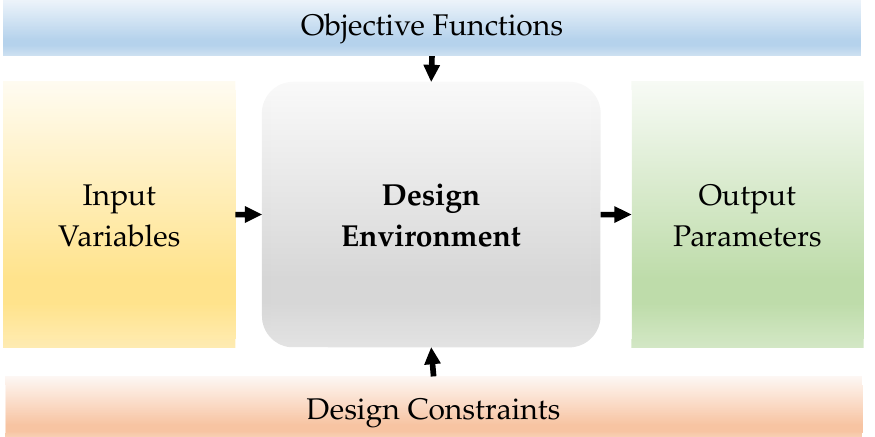
Figure 4. Inductor Design via Simulation Driven Approach .